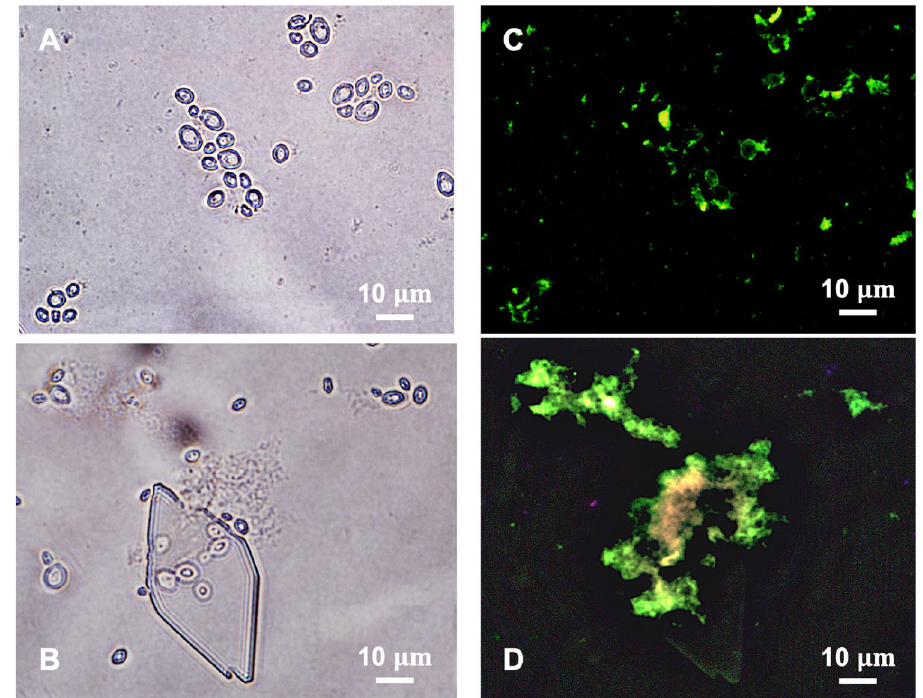
Figure 9. Optical microscope images of the fluorescent lysozyme before nucleation ( A ) and after nucleation ( B ), and corresponding fluorescence microscope images ( B ) and ( D